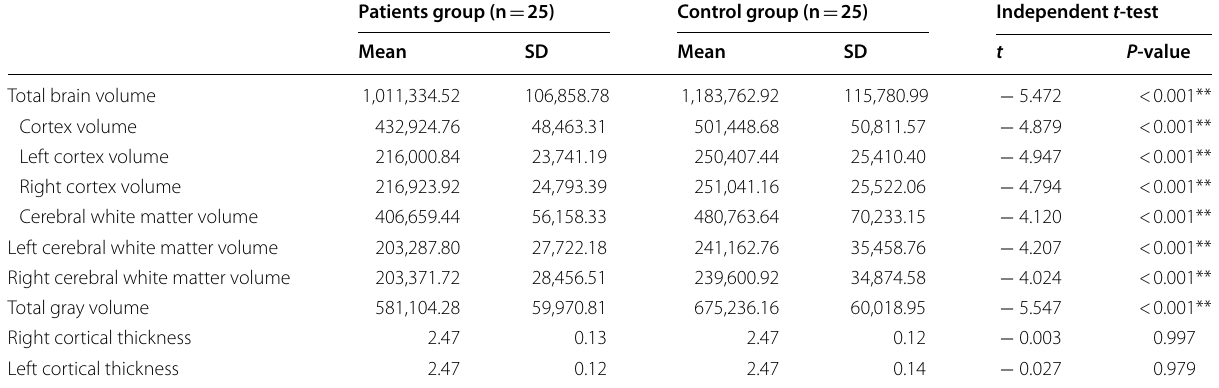
Table 2 Comparison between patients and control groups as regards total brain volumetry (mm 3 ) and cortical thickness parameters (mm)